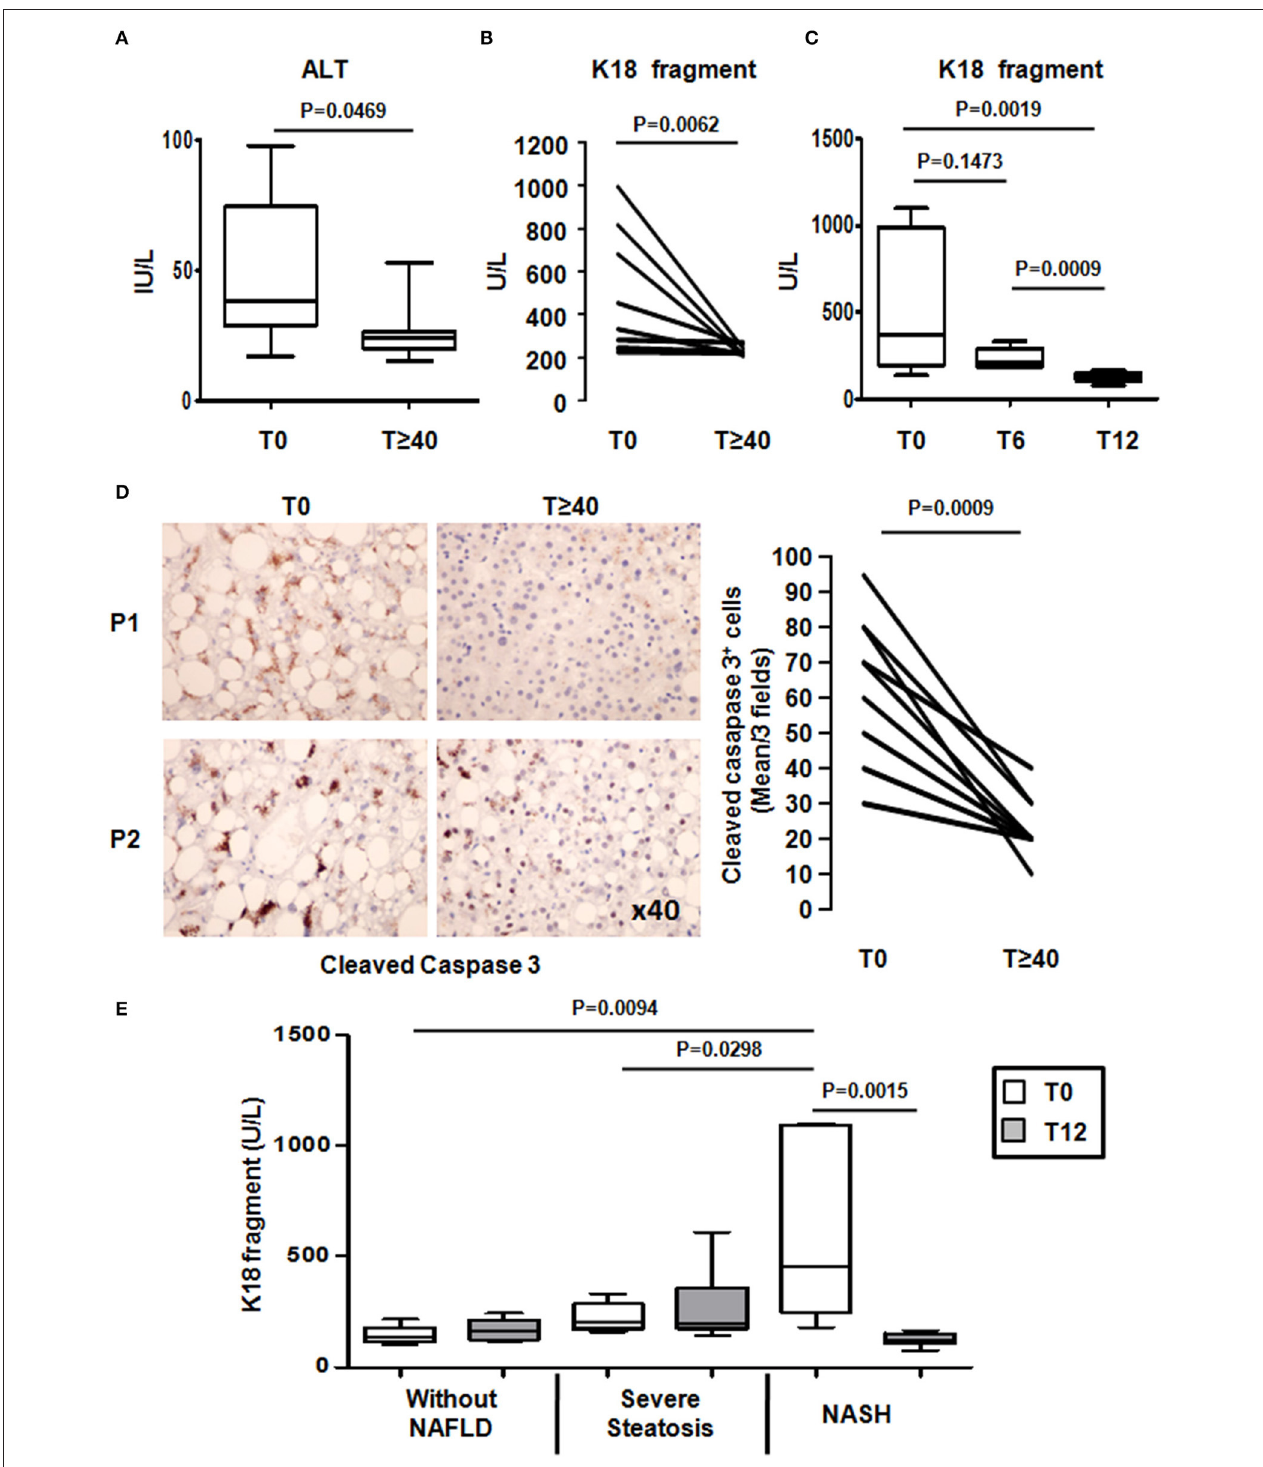
FIGURE 3 | LRYGB improves liver injury and hepatocyte apoptosis in NASH patients after a median follow-up of 55 months. Serum levels of (A) alanine aminotransferase (ALT) and (B) a marker of hepatocyte apoptosis [caspase-generated keratin 18 fragment (K18 fragment)] and (D) hepatic levels of cleaved caspase 3 were evaluated at baseline and at the median follow-up of 55 [44; 75] months after LRYGB in NASH patients. The levels of K18 fragment were also evaluated (C) at 6 months and at 1 year after a LRYGB and, (E) at baseline (T0) and 1 year (T12) after LRYGB in three additional groups of patients without NAFLD ( n = 5), severe steatosis ( n = 7), or NASH ( n = 7). Results are expressed as the median [25th, 75th percentiles] (A,C,E) .